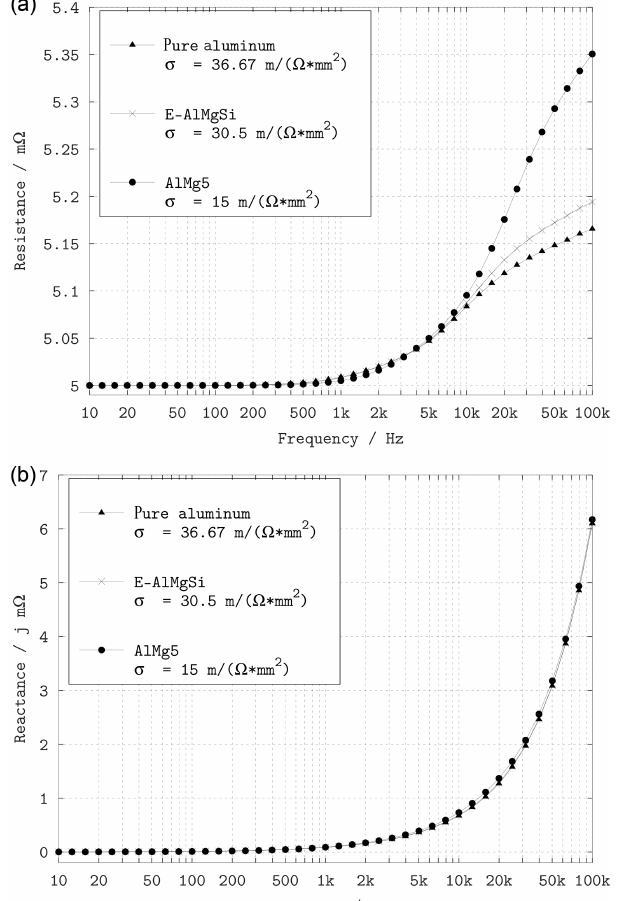
Figure 5. Simulation of the shunt resistance (the real part in a ) and the shunt reactance (the imaginary part in b ) with different conduc- tance values of the aluminum mounting body and carrier